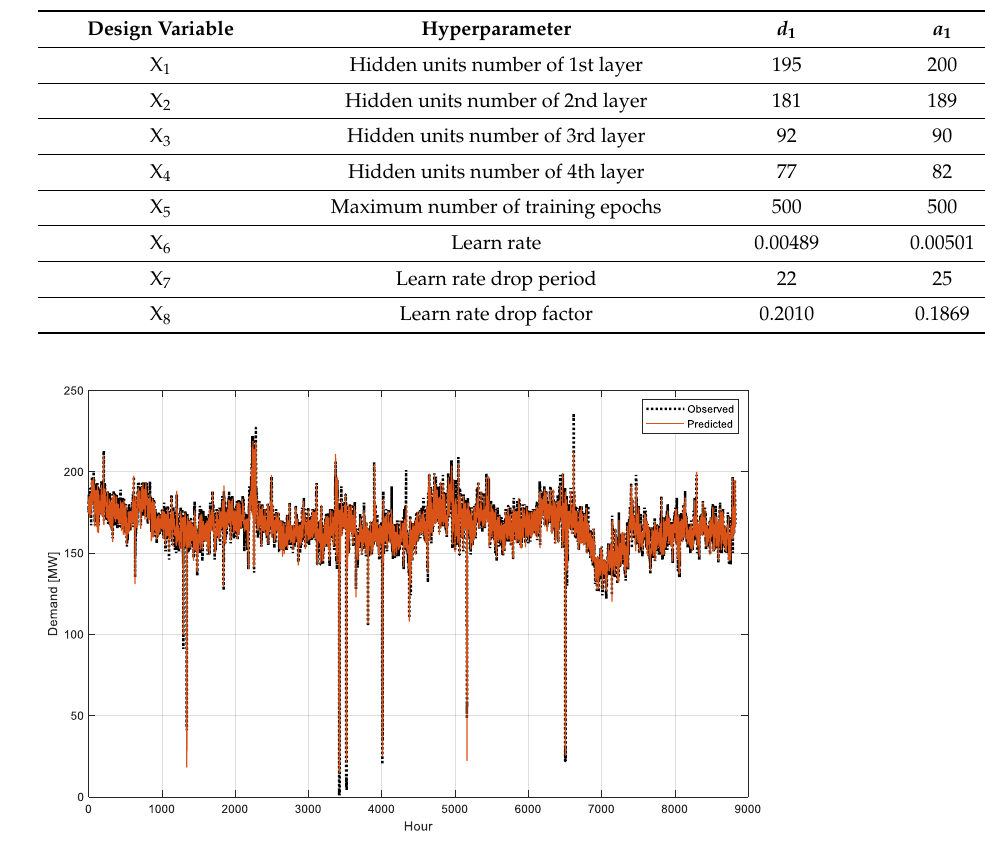
Table 2. Optimal hyperparameters of LSTM for demand forecasting obtained by the ELATLBO.